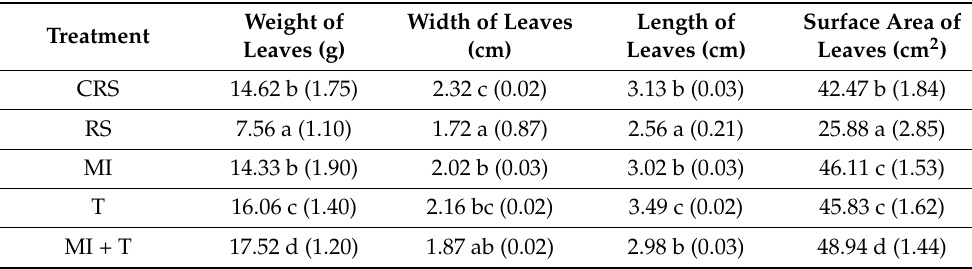
Table 7. The apple leaf growth parameters (CRS = crop rotation soil; RS = replanted soil;